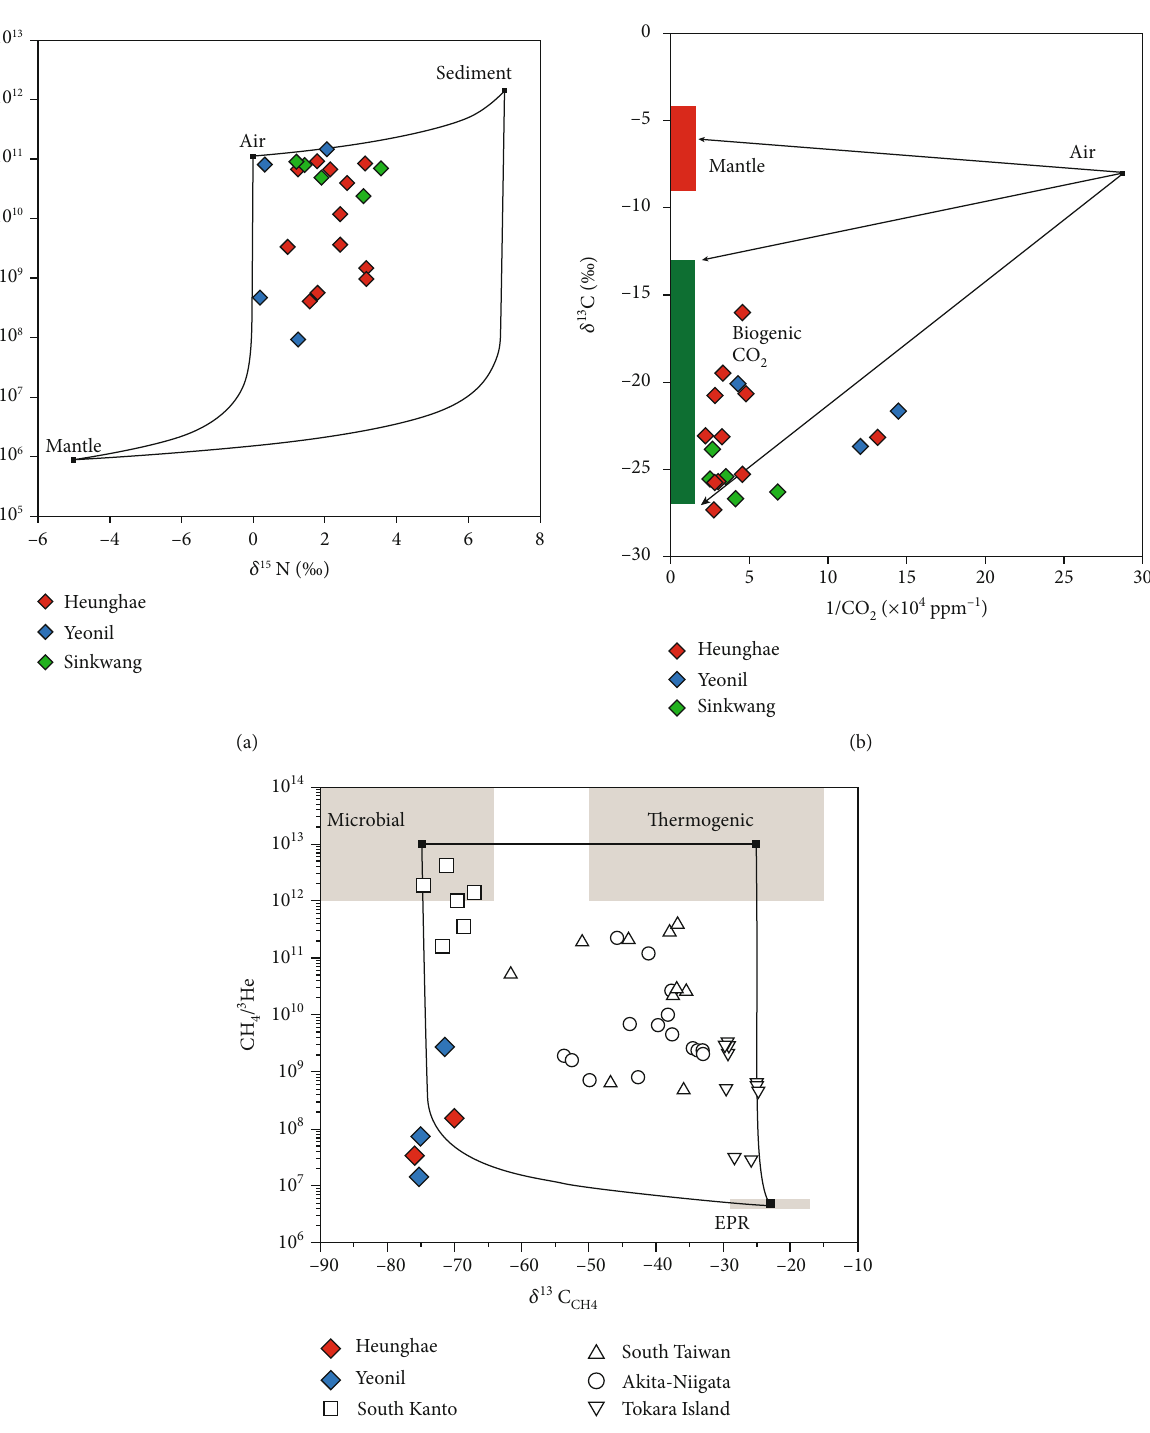
Figure 3: (a) N / 3 He versus δ 15 N diagram. Each end-member and mixing lines are described in section 4.2. (b) δ 13 C of CO 2 diagram (modi fi ed from Lee et al. [53]). Mantle value of δ 13 C ( − 6 : 5 ± 2 : 5 ‰ ) is from Sano and Marty [30]. The biogenic CO between δ 13 C values of C3 plant and C4 plant [31]. The air value of δ 13 C and CO CH / 3 He versus δ 13 C of CH diagram (modi fi ed from Sano et al. [55]). Reference data from northeastern Asia is shown together (Sano 4 4 et al.